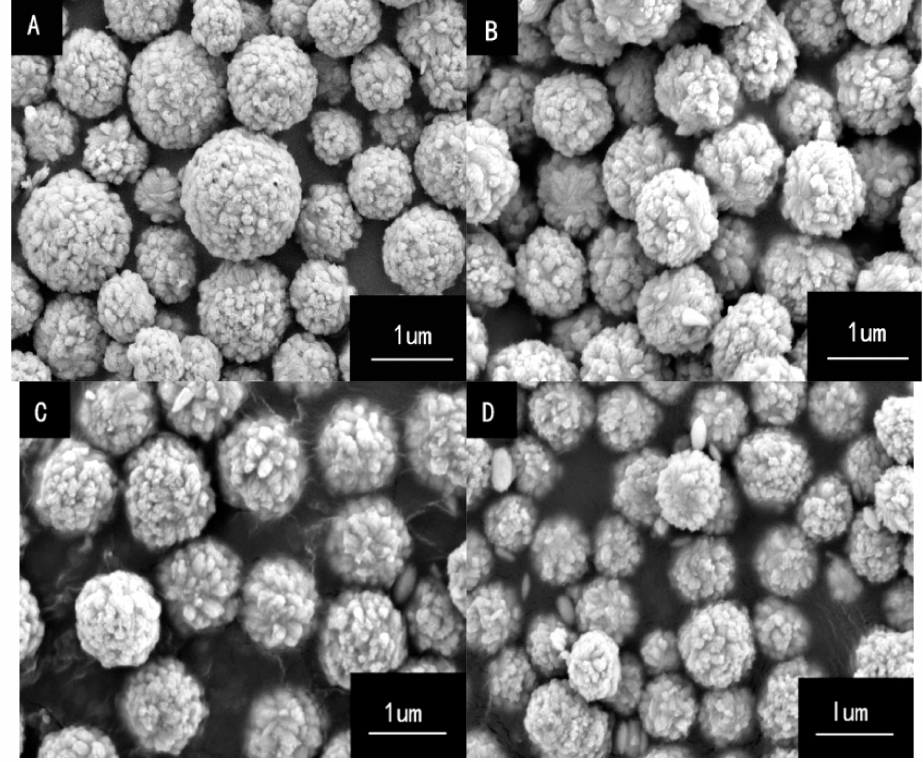
Figure 3. SEM of BaSO 4 at different stirring rates: ( A ) 0 r/min, ( B ) 250 r/min, ( C ) 500 r/min, ( D ) 750